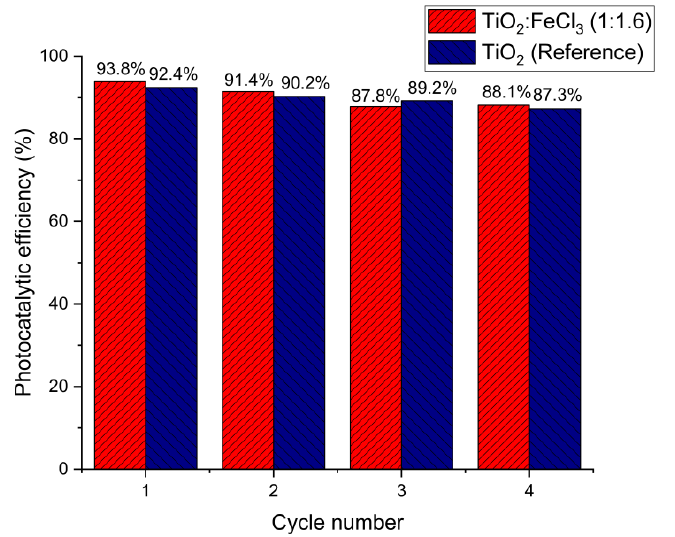
Figure 7. Recycling of TiO 2 :FeCl 3 (1:1.6) and TiO 2 (reference) for degradation of RhB dye.